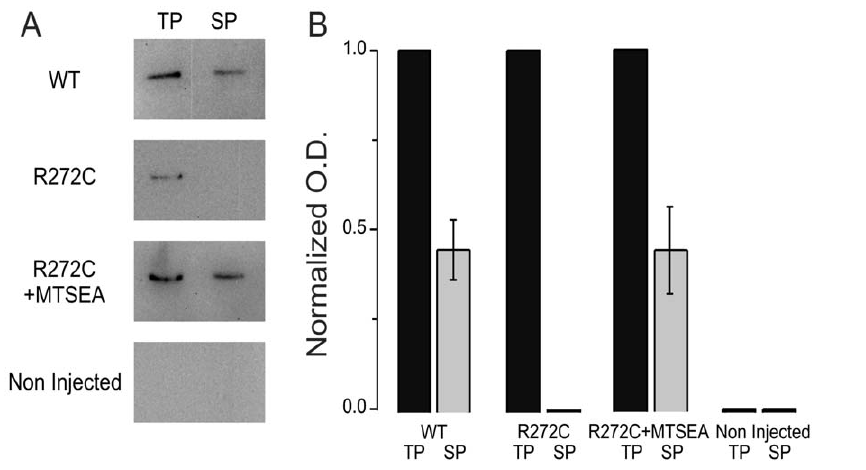
Figure 4. Cell surface expression of CNGA1-GFP channels. A. Representative Western blot of total CNGA1-GFP protein (TP) and biotinylated CNGA1-GFP cell surface protein (SP). WT, R272C, R272C + MTSEA denote cysteine-less CNGA1-GFP, mutant channels that were not treated with MTSEA and mutant channels that were modified by MTSEA, respectively. An expected band of , 106 kDa for the deglycosylated wild-type GFP tagged channel was detected by chemiluminiscence using a GFP antibody. No signal was detected in non injected oocytes. B. Densitometry analysis of the bands normalized to TP (n=3 different oocytes batches).